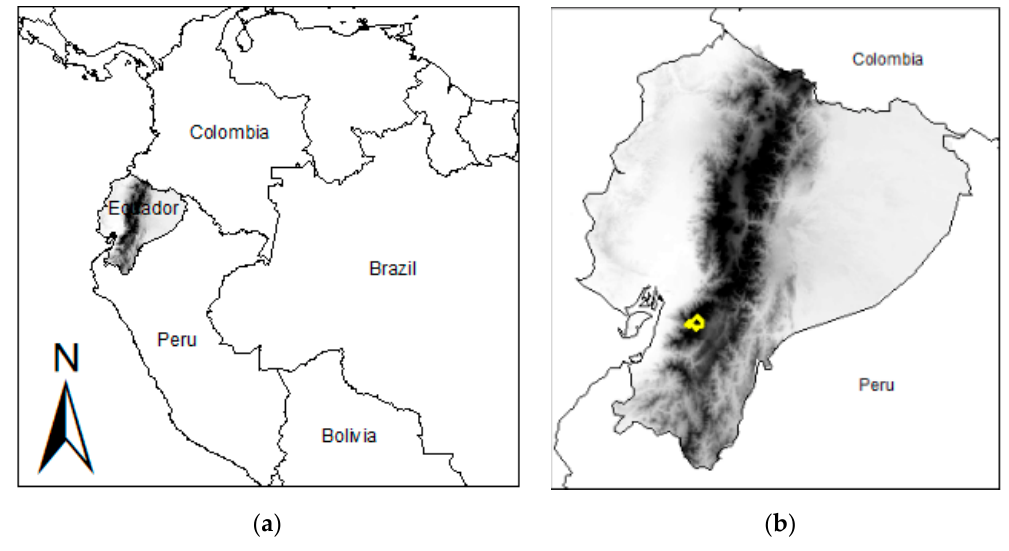
Figure 1. Location of study region. ( a ) Ecuador within South America. ( b ) Cajas National Park in Ecuador.